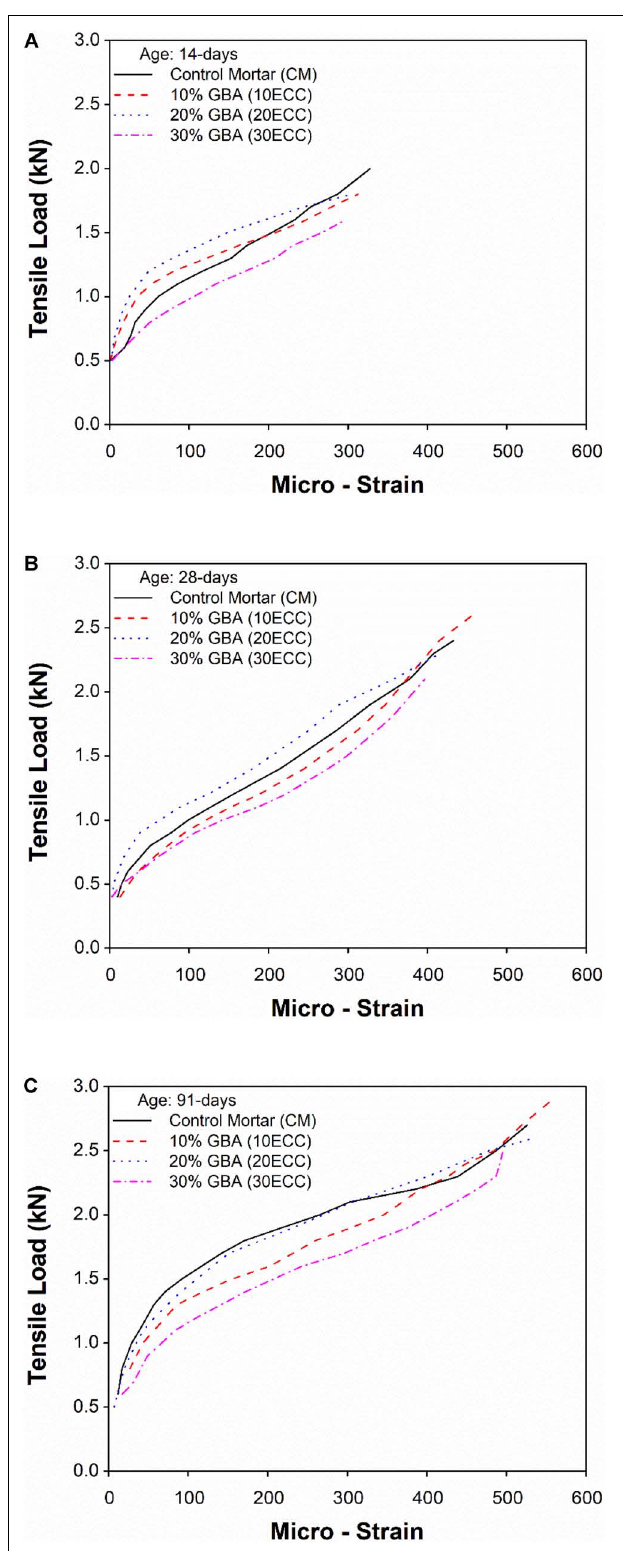
FIGURE 7 | Comparison of tensile strength with aging among CM and ECC mixes containing different percentages of GBA.